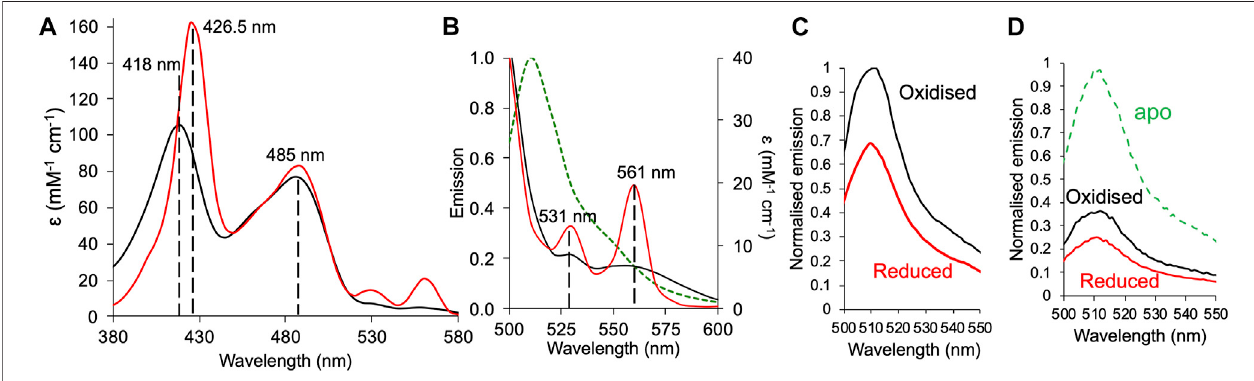
FIGURE 4 | Redox dependent fluorescence emission of GFP b 204-71 . (A) Absorbance spectra of GFP b 204-71 under oxidising (black line) and reduced (red line). Reducing conditions stimulated by addition of a 10-fold molar excess of DTT. (B) Absorbance spectra under oxidising and reducing conditions shown in (A) for the α / β peak region overlaid with the emission spectrum (on excitation at 485 nm) of sfGFP (green dashed line). (C) Emission spectra of 1 μ M GFP b 204-71 in the absence (oxidised; black) and presence (reduced; red) of DTT. Spectra were normalised to oxidised holo-GFP b 204-71 . (D) The emission spectra of apo-GFP b 204-71 before the addition of haem under oxidising (black line) or reduced (red line) conditions. Spectra were normalised to apo-GFP b 204-71